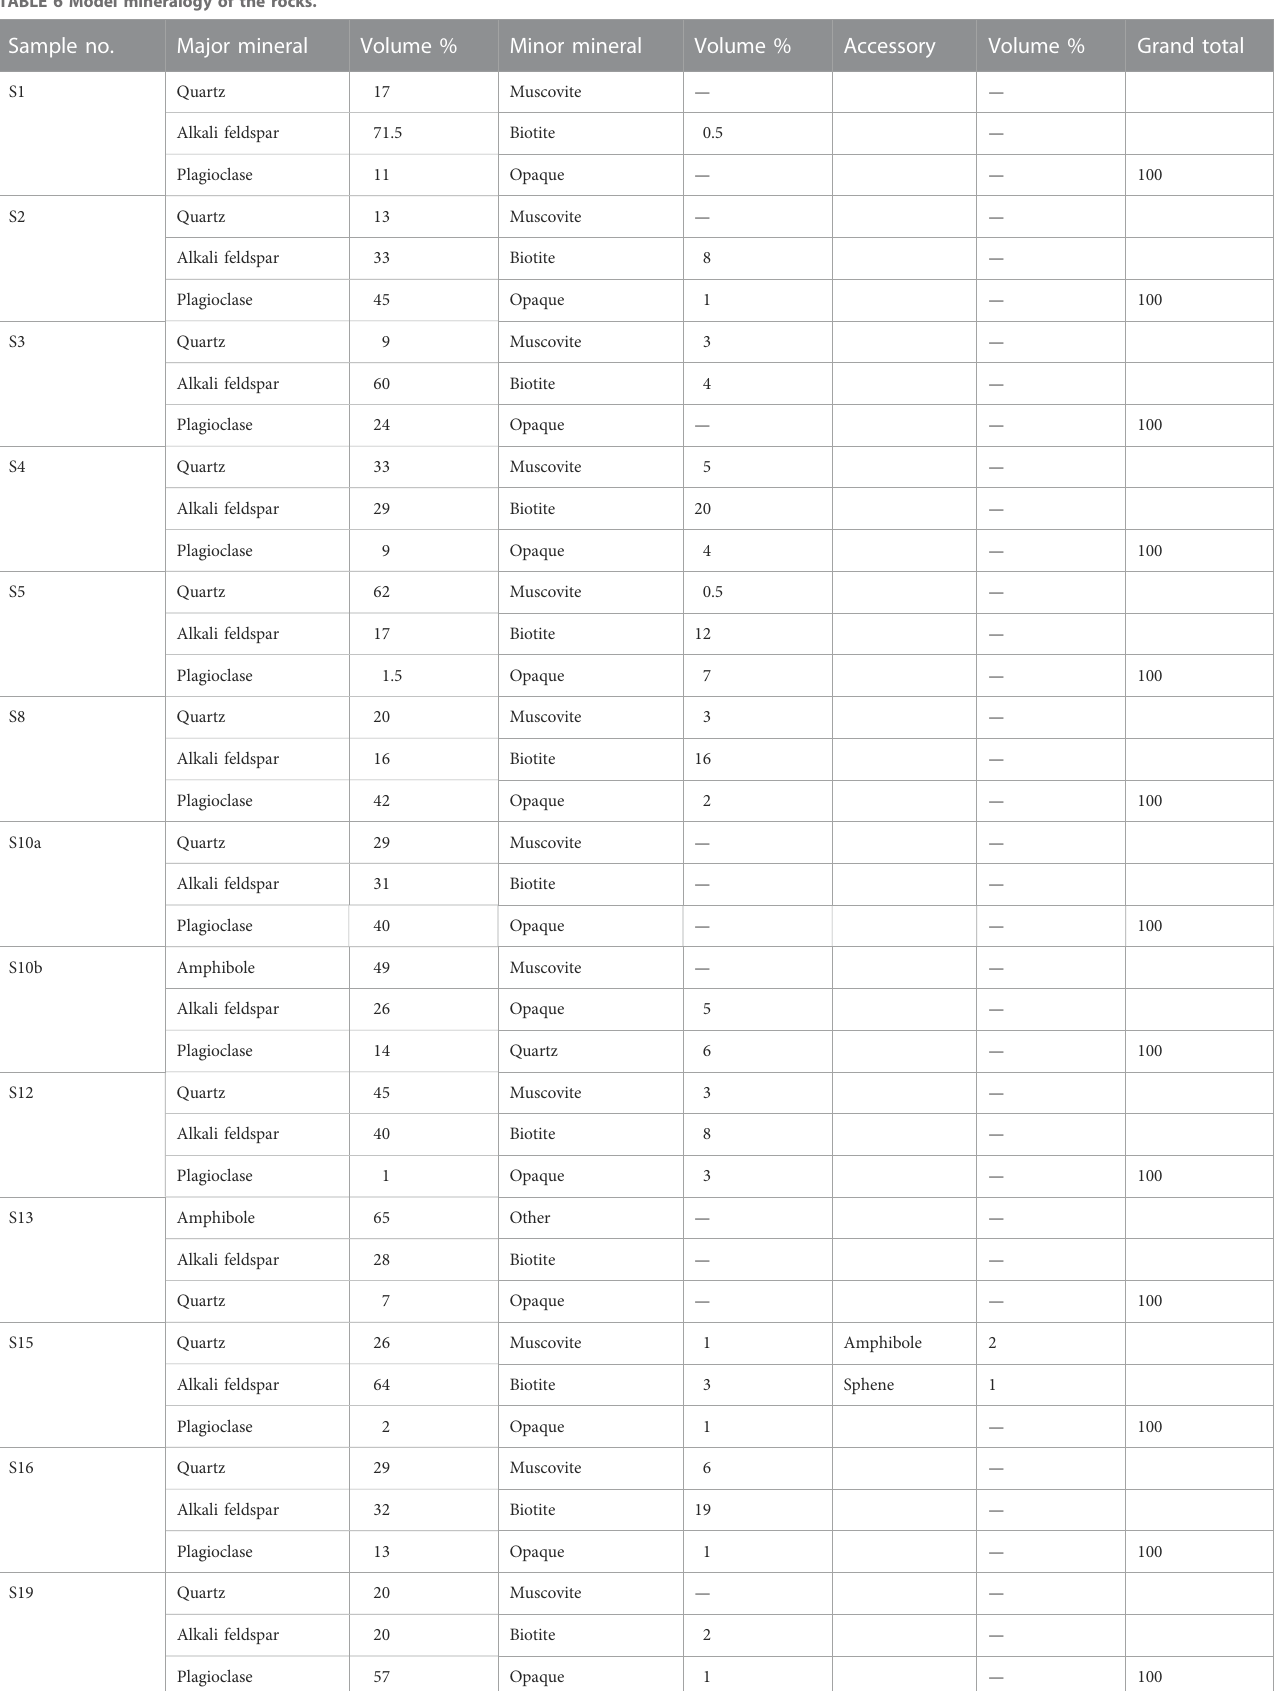
TABLE 6 Model mineralogy of the rocks. Sample